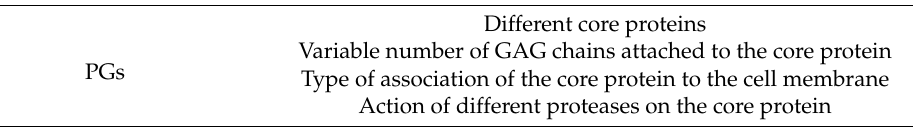
Table 1. List of the features that contribute to the high structural heterogeneity of GAGs/PGs. Combinations of hexuronic acids and amino sugars Length of the saccharide chain Positions of sulfated groups (sulfatase activity) Degree of sulfation (sulfatase activity) Distinctive expression profiles in different cell types GAGs/PGs Distinctive expression profiles in different tissues Changes of expression profile during cell differentiation Changes of expression profile from physiology to pathology Localization in intra- or extracellular compartments Action of different glycosidases on the GAG chain Different core proteins Variable number of GAG chains attached to the core protein PGs Type of association of the core protein to the cell membrane Action of different proteases on the core